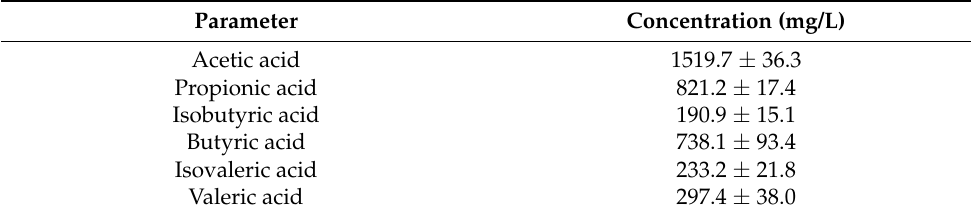
Table 3. VFA analysis in RCWW, using GC–FID ( n =